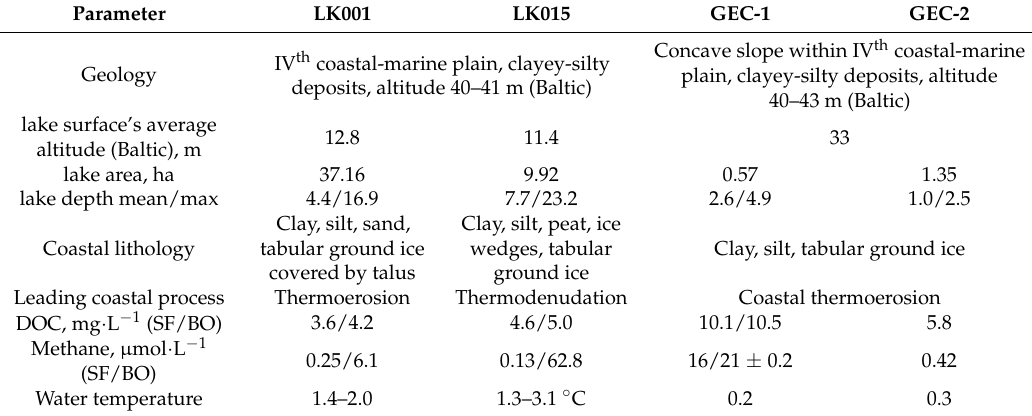
SF: surface water, BO: bottom